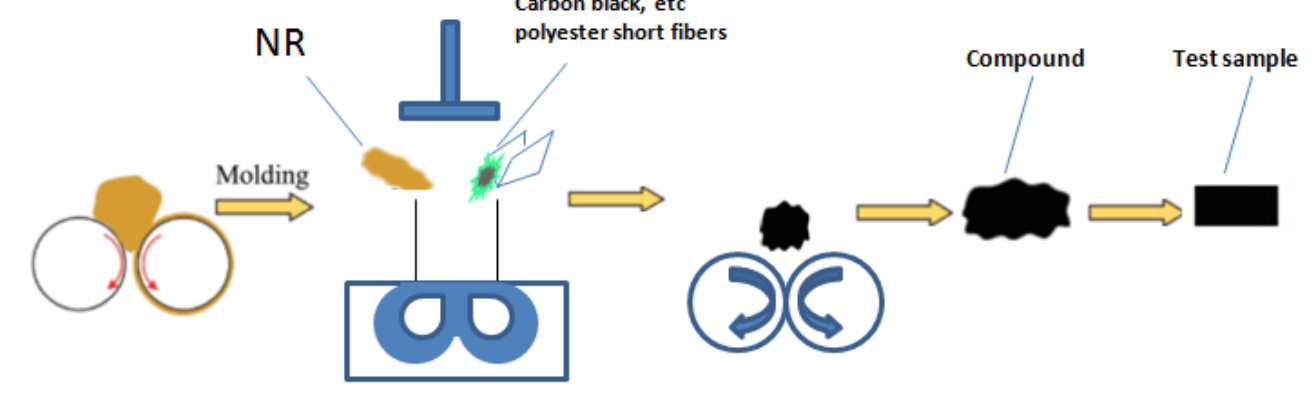
Figure 2. Mixing